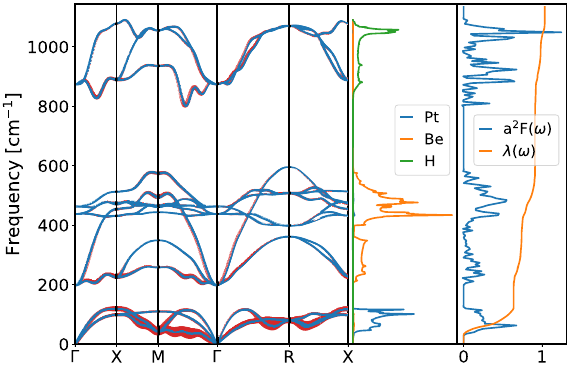
Fig. 3 Calculated phonon dispersion curves (left), projected phonon density-of-states (center), α 2 F ( ω ) and λ ( ω ) (right) for PtHBe 3 . The red circles represent the phonon linewidths with radius proportional to the respective electron – phonon coupling strength.